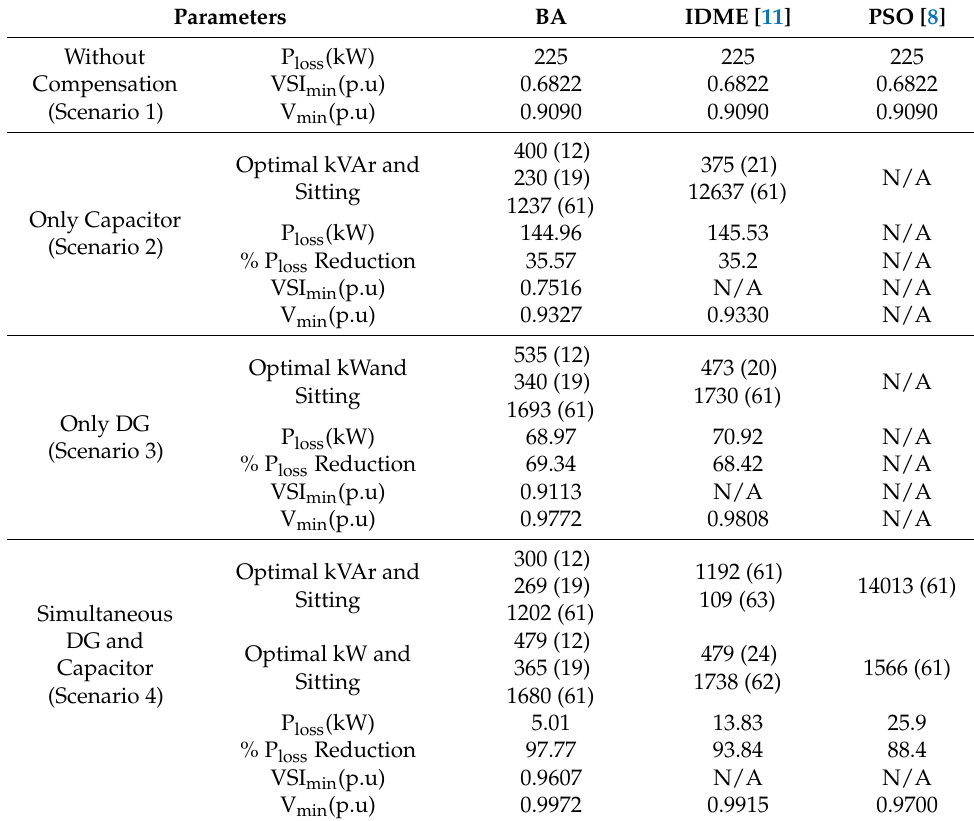
Table 6. Results of IEEE 69-RDS (constant load model).